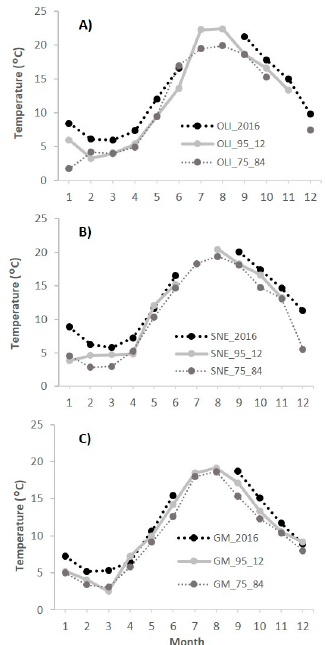
Figure 5. Monthly SST averages showing warming trends in the NE area for three di ff erent sectors: ( A ) O ff shore Long Island (OLI), ( B ) Southern New England (SNE) and ( C ) Gulf of Maine (GM), in the last decades. Lines show recent 2016 year and in the past 1995–2012 and 1975–1984. The legend for each line is a combination of place and years, for example, OLI_95_12 refers to O ff shore Long Island period 1995–2012. There were no summer data for the year 2016, thus, the lines for that year are not continuous.